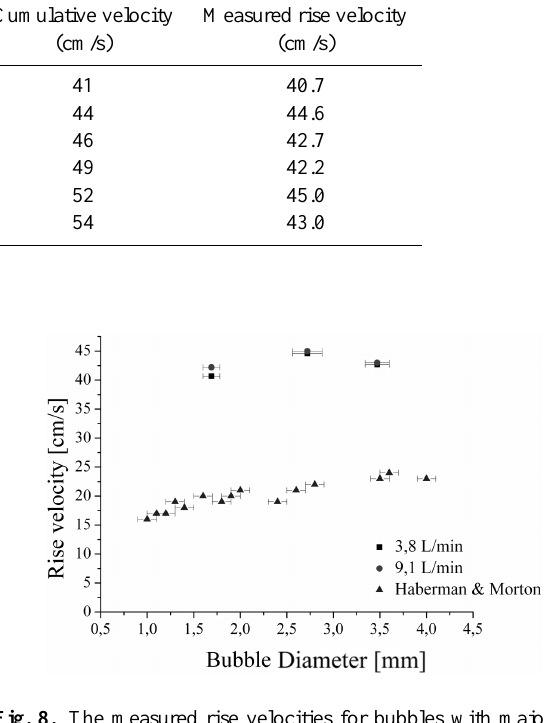
Fig. 8. The measured rise velocities for bubbles with major axis diameters of 1.7mm, 2.7mm and 3.5mm are plotted for each flow rate. The rise velocity error is given by 2mm/s and equals the size of the plotted objects. Additionally, the terminal velocity measured by Haberman and Morton is shown. The difference between bubble rise velocity and terminal velocity may indicate liquid bulk